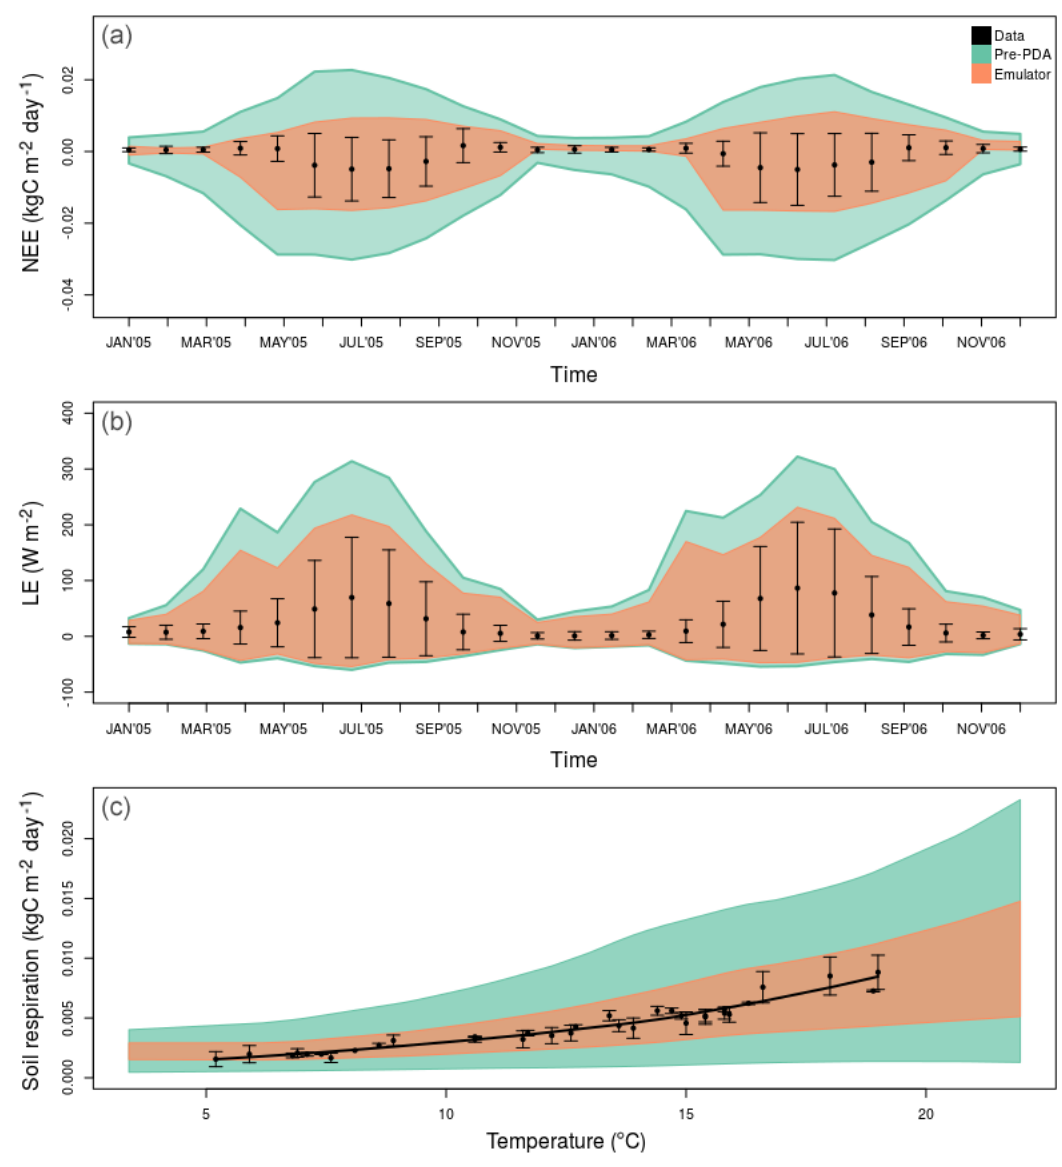
Figure 6. Pre-PDA vs. post-PDA ED2 performance against real-world data. Panels and colors are the same as in Fig.